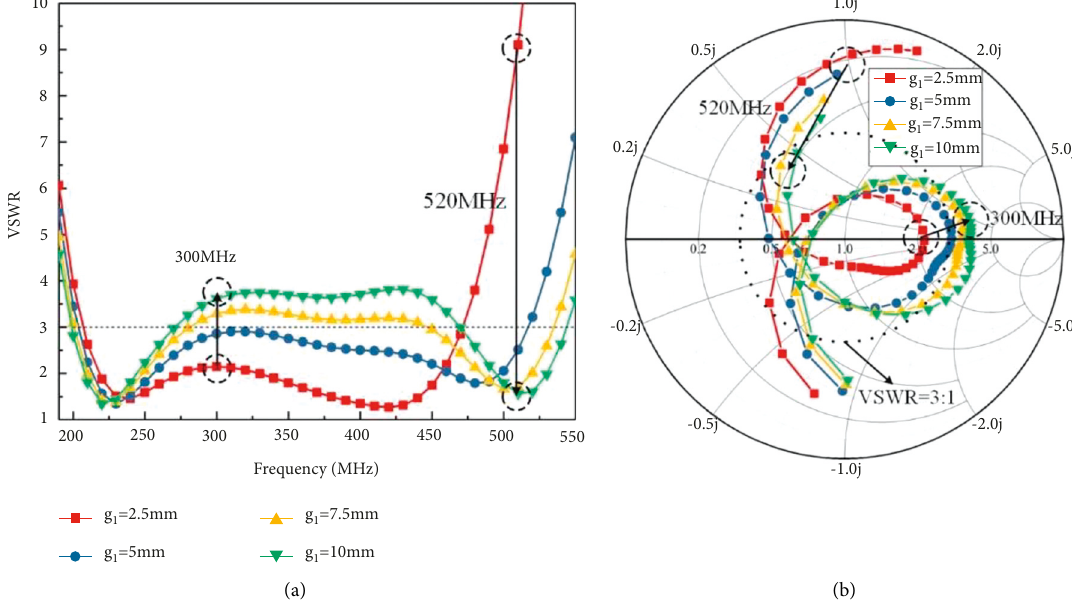
Figure 10: (a) VSWR curves and (b) Smith charts with different values of g